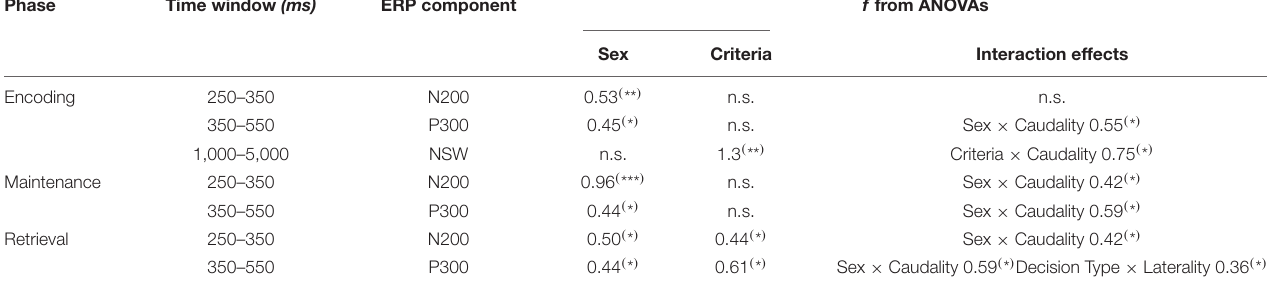
TABLE 1 | Main significant results from analysis of variances (ANOVAs) on event related potentials (ERPs) amplitudes in the three phases ( f : effect size; p , significance in brackets after Bonferroni correction, simple * p < 0.05; ** p < 0.01; and *** p < 0.001).